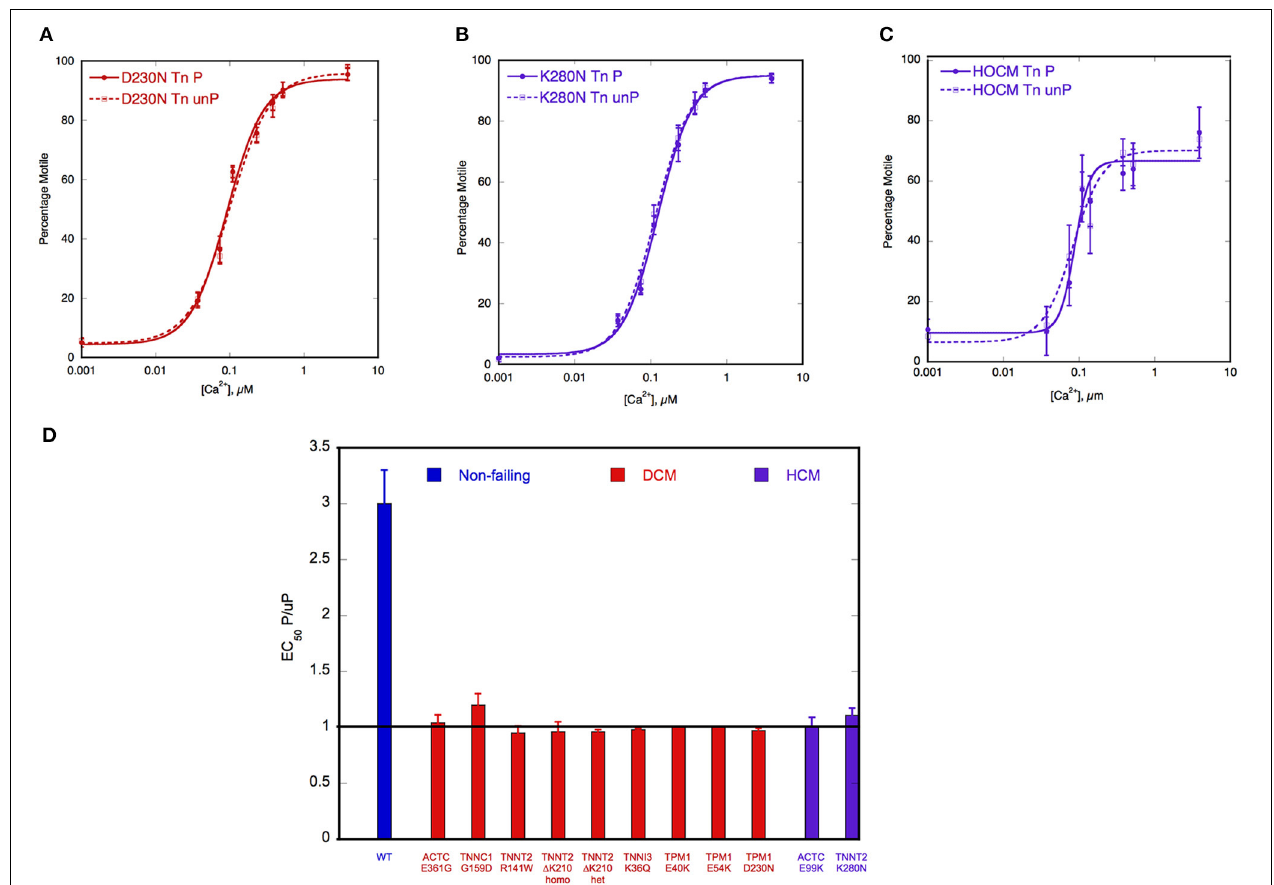
FIGURE 3 | Demonstration of uncoupling due to DCM and HCM mutations and secondary to HOCM. Thin filament motility was measured by motility assay over a range of [Ca 2 + ] in paired cells. The percentage of filaments motile is plotted as a function of [Ca 2 + ] for a representative experiment. Solid lines and points, phosphorylated thin filaments, dotted line and open points, unphosphorylated thin filaments (obtained by phosphatase treatment). The points ± s.e.m. are the mean of four determinations of percentage motile measured in one motility cell. The curves are fits of the data to the Hill equation. (A) Natively phosphorylated and unphosphorylated human donor heart Tn with DCM related α - tropomyosin D230N (100%) and